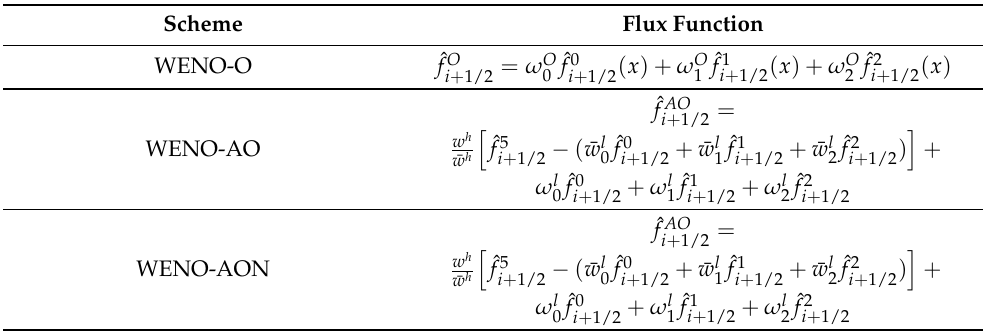
Table 1. Comparison of flux function of the adaptive order schemes (WENO-AO and WENO-AON) and proposed WENO-O scheme.